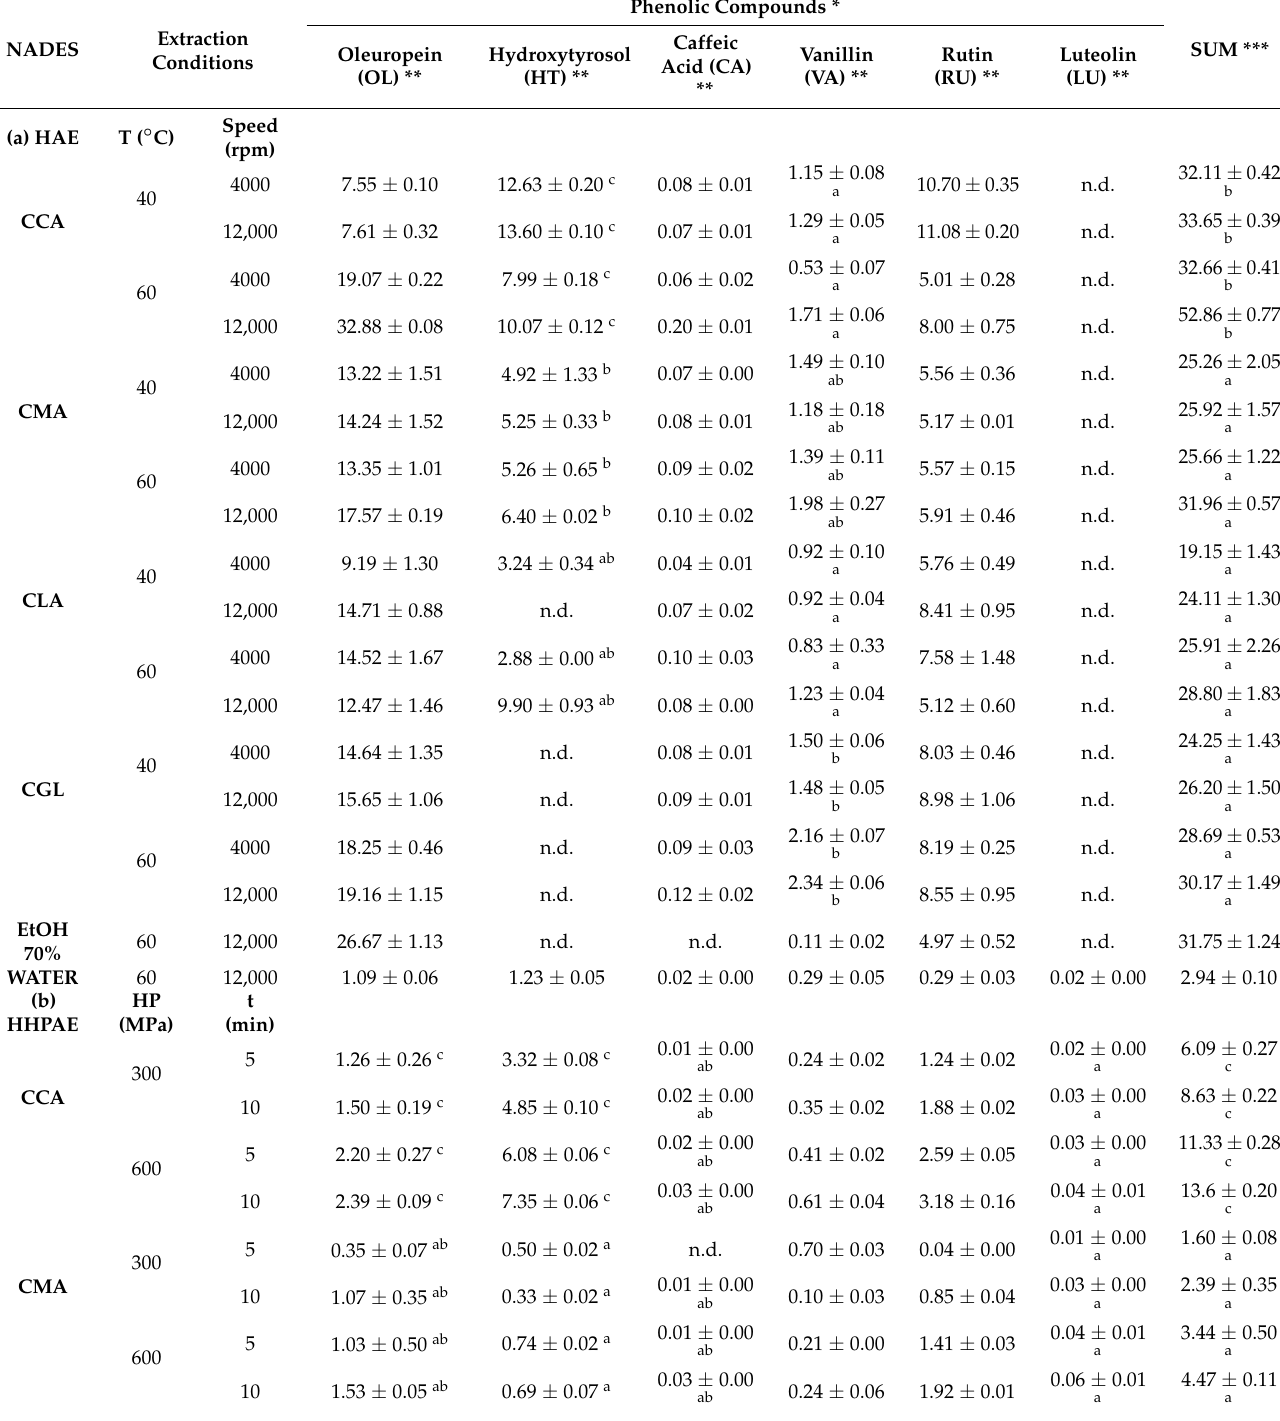
Table 3. Effect of NADES on the identified phenolic compounds (using HPLC) extracted from olive leaves using HAE (a) and HHPAE (b) and comparison with conventional